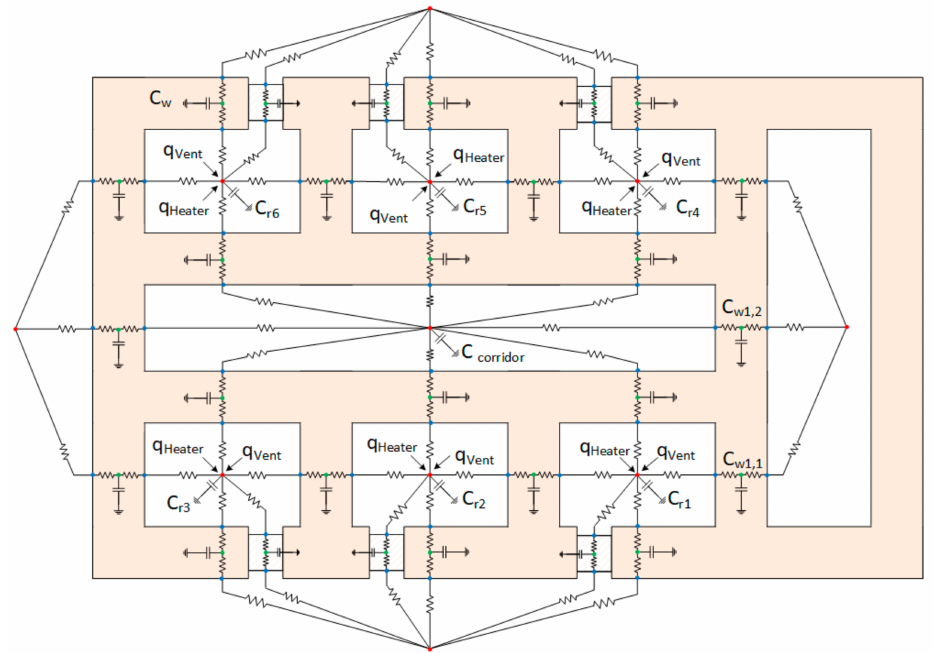
Figure 2. Schematic of the equivalent lumped-capacitance model for an office building with six rooms and one corridor.